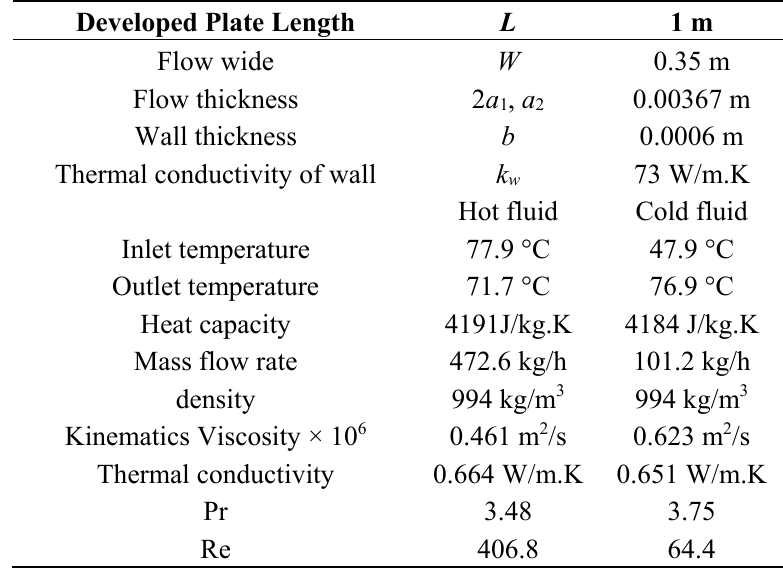
Table 2. Plate dimensions and flow